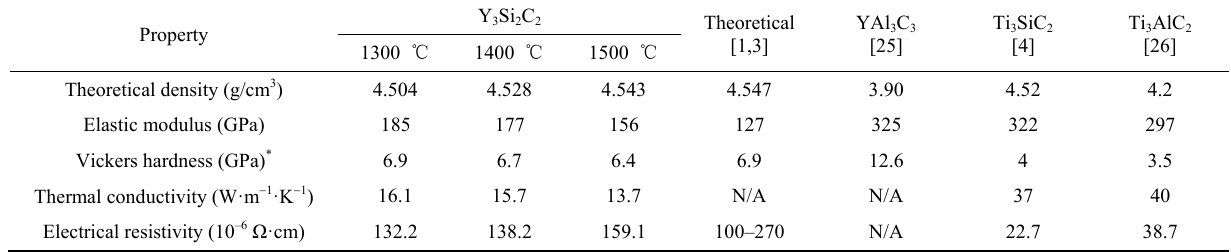
Table 3 Density, mechanical, thermal, and electrical properties of the as-obtained Y 3 Si 2 C 2 , and their comparison with the reported values of typical ternary layered structural ceramics Property